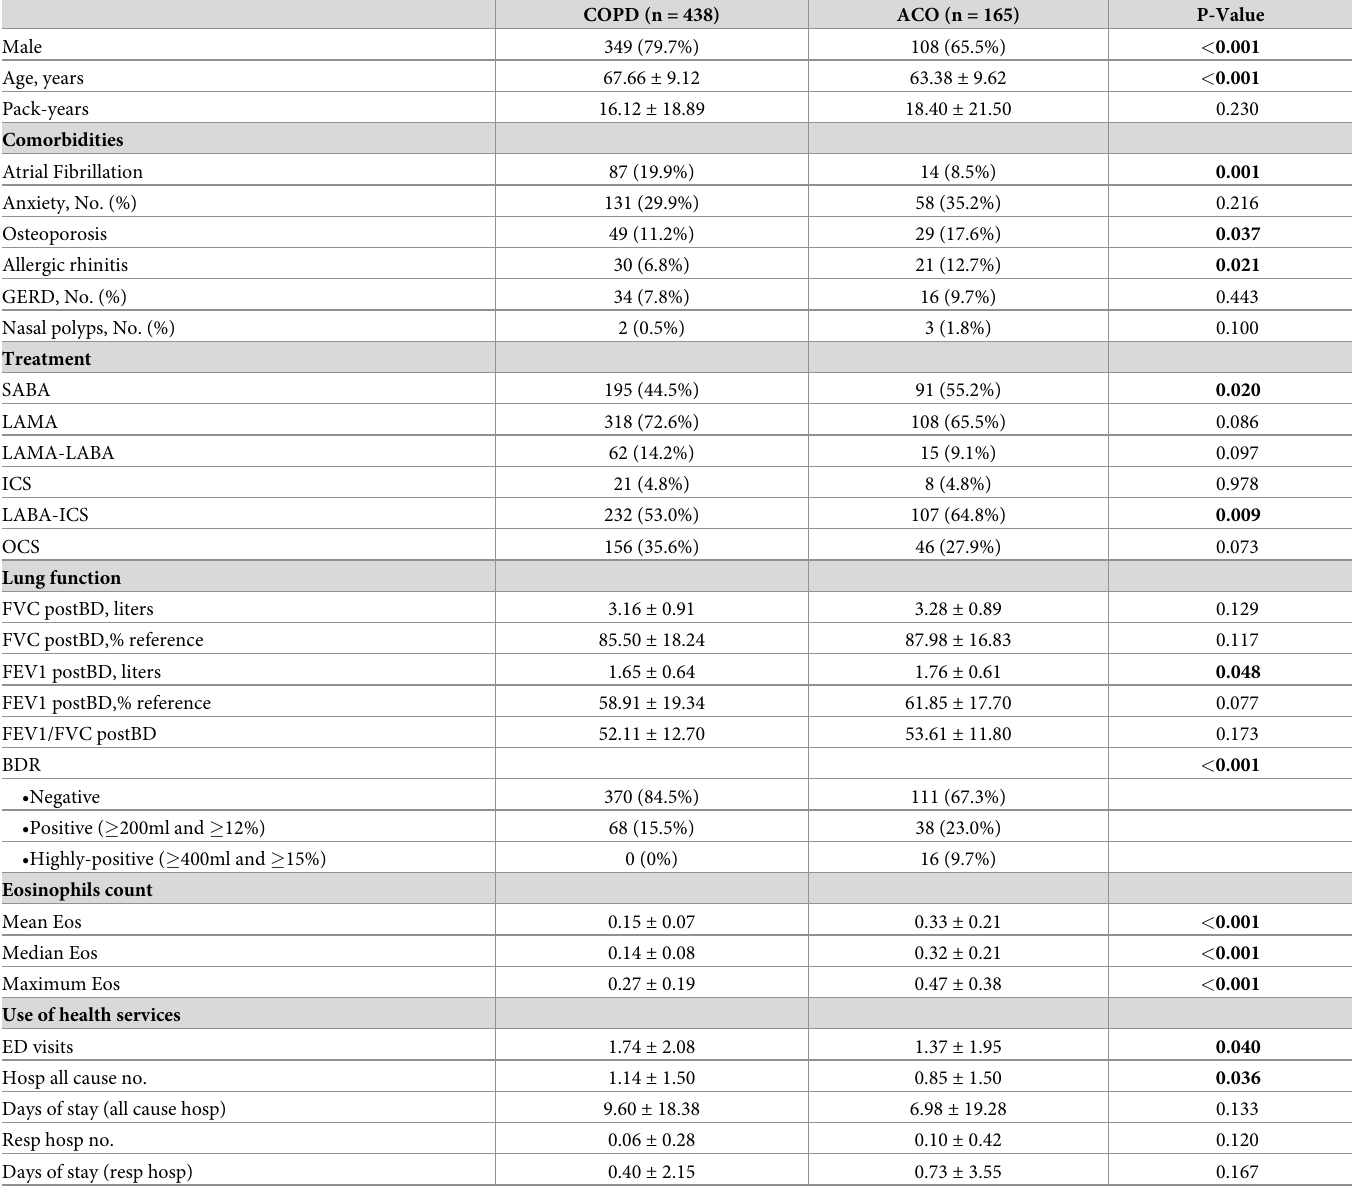
Table 1. Demographic and clinical characteristics of COPD and ACO